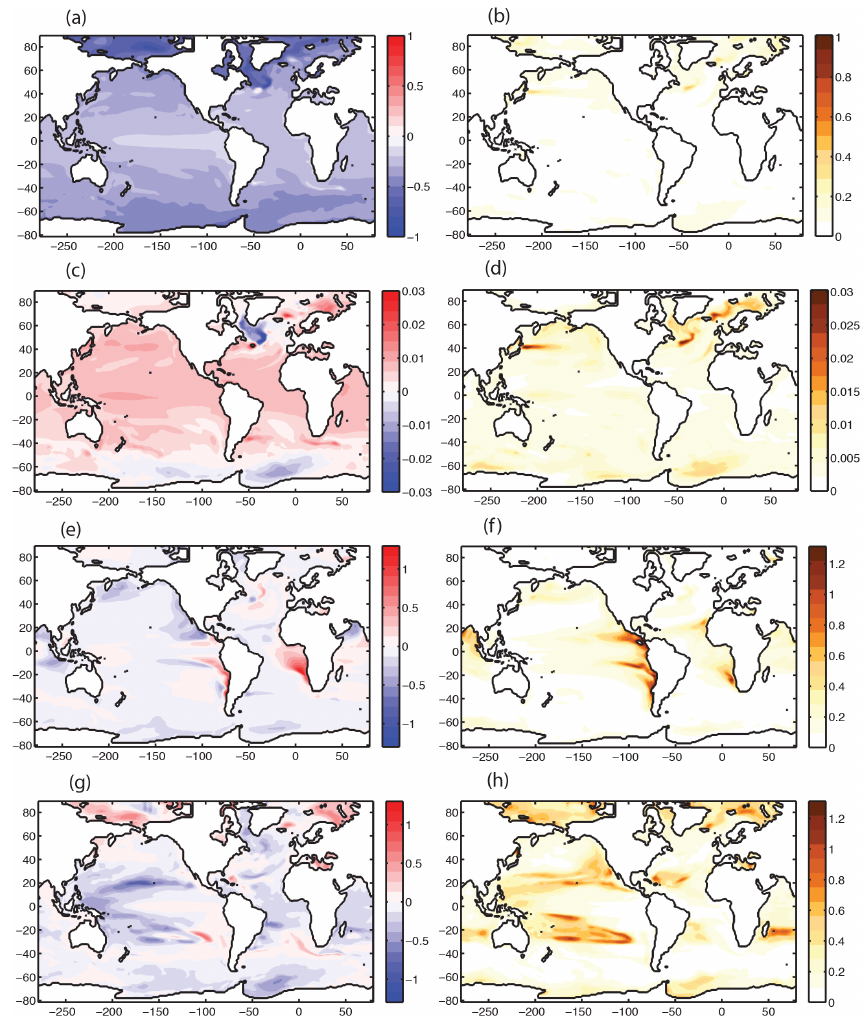
Figure A1. Linear trends (left) and standard deviations of the linear trends (right) for (a, b) (cid:127) arag (c, d) SST (e, f) O 2 inventories from 100 to 600m, and (g, h) net primary production averaged over 2005–2014. All fields are calculated using 30-year trend windows, and the trends are shown in units of